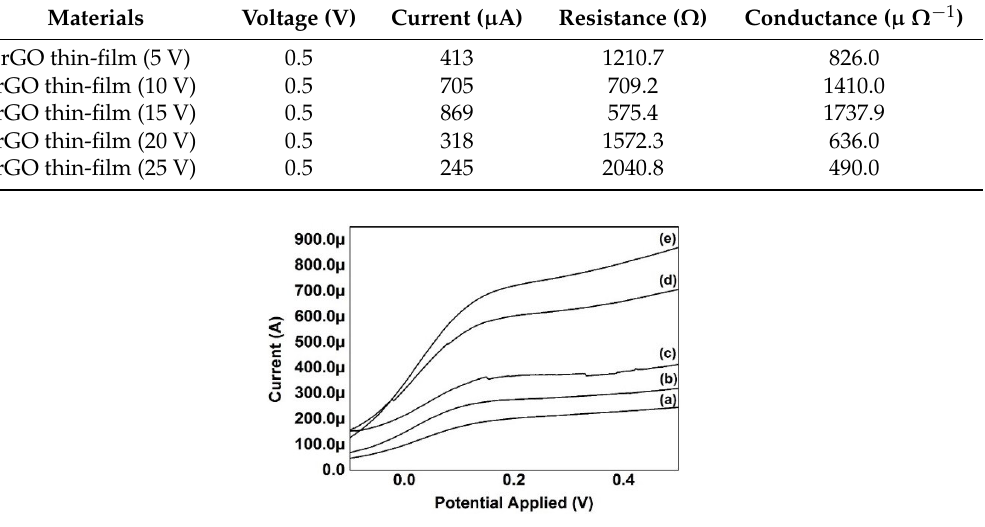
Figure 9. Current–voltage curves generated by AutoLab system for GO electrochemically reduced at ( a )25 V, ( b ) 20 V, ( c ) 5 V, ( d ) 10 V, and ( e ) 15 V. ( a ) 25 V; ( b ) 20 V; ( c ) 5 V; ( d ) 10 V; and ( e ) 15 V.